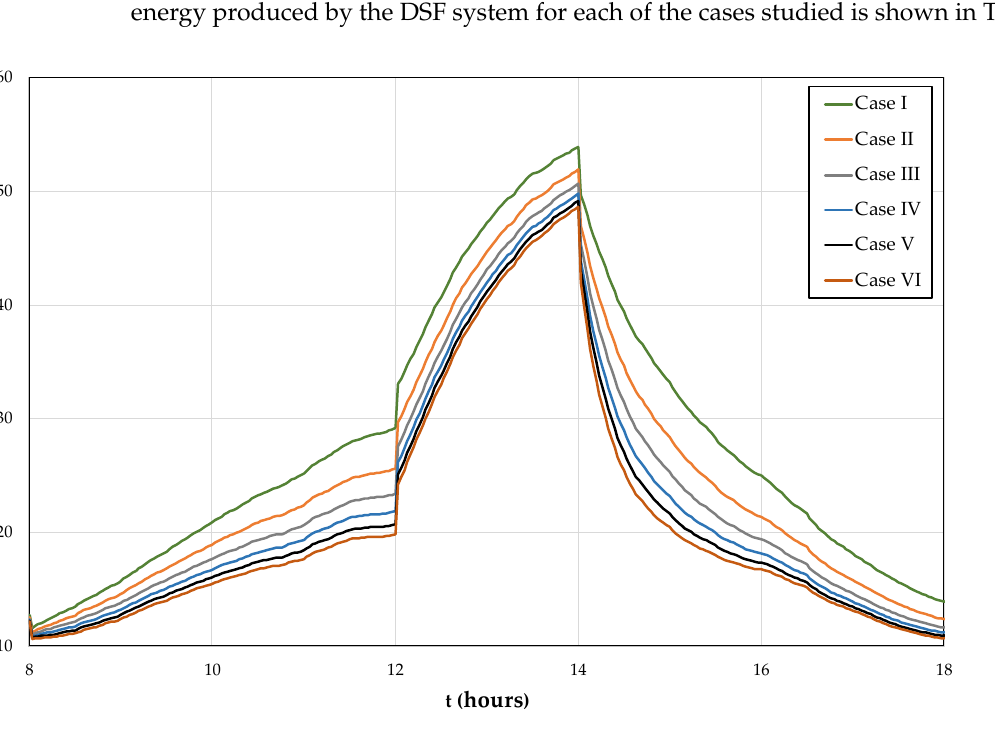
Figure 5. Evolution of the air temperature (Tair) inside the DSF for each of the cases studied. The virtual chamber is occupied between 8 and 12 h and between 14 and 18 h. Table 3. Input data of the inlet and outlet temperatures at 10 h and at 16 h.